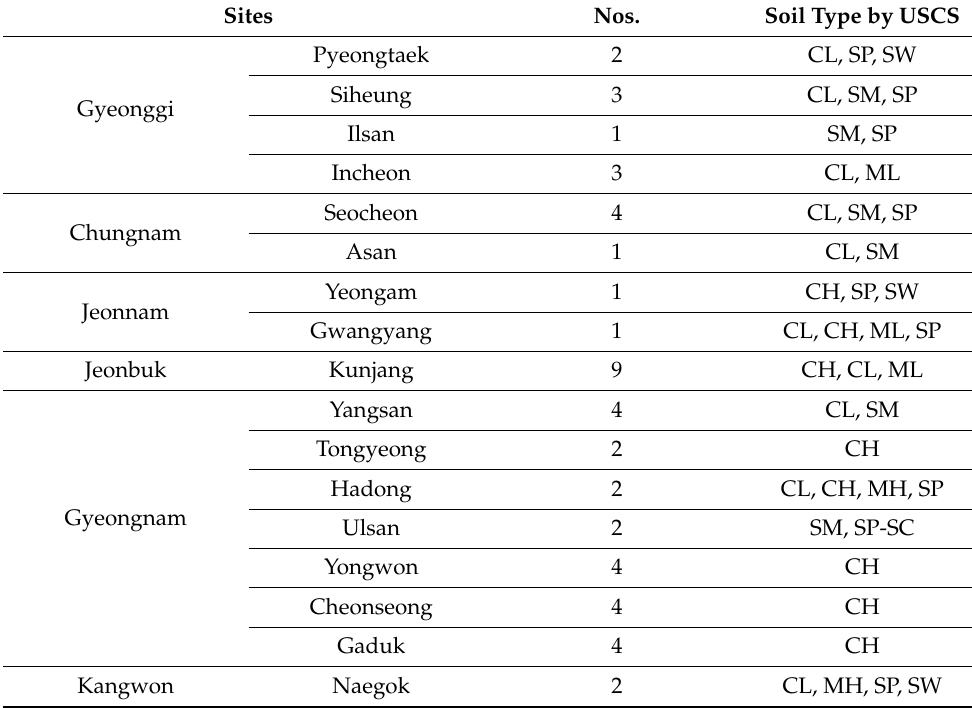
Table 1. Included number of PCPTs and USCS classes for each site. Sites Nos. Soil Type by USCS